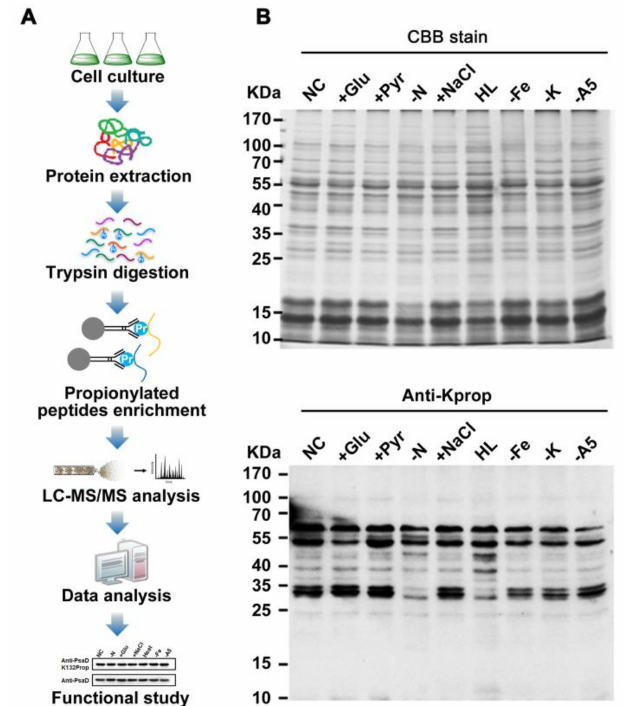
Figure 1. Profiling lysine propionylation in Synechocystis sp. PCC 6803. ( A ) Flowchart illustrating the experimental procedure for lysine propionylation analysis. ( B ) Profiling of lysine propionylation in Synechocystis under various stresses. Total proteins (20 µ g) were extracted from the cells cultured under glucose treatment ( + Glu), sodium pyruvate ( + Pyr), nitrogen deficiency ( − N), sodium chloride ( +